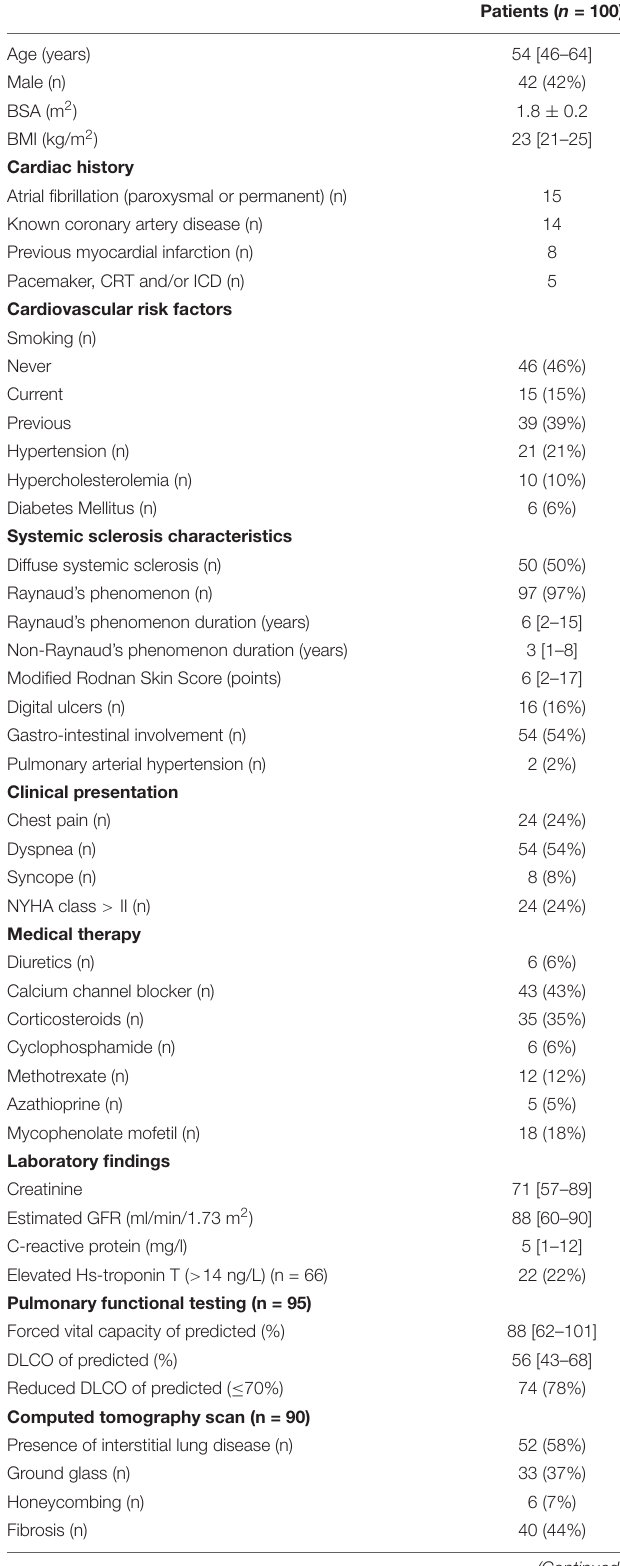
TABLE 1 | Baseline characteristics of systemic sclerosis